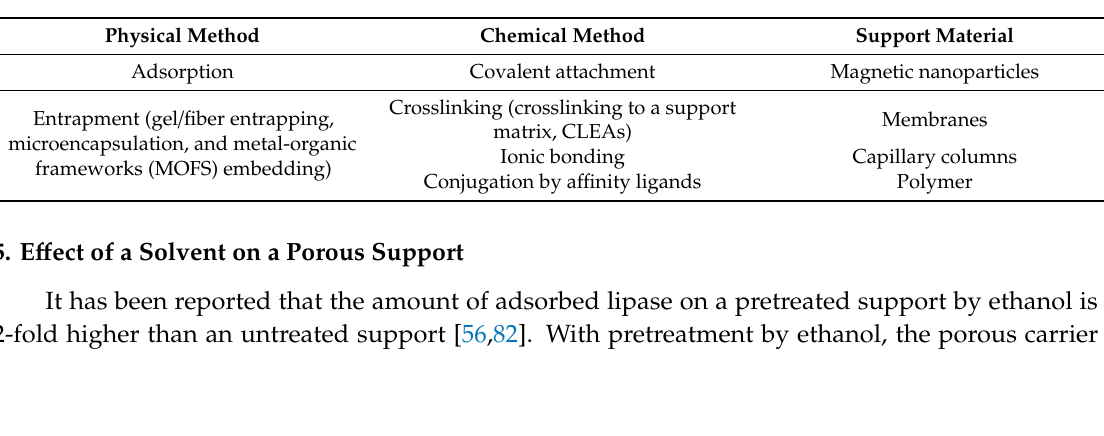
Table 2. Immobilization methods and supports materials.